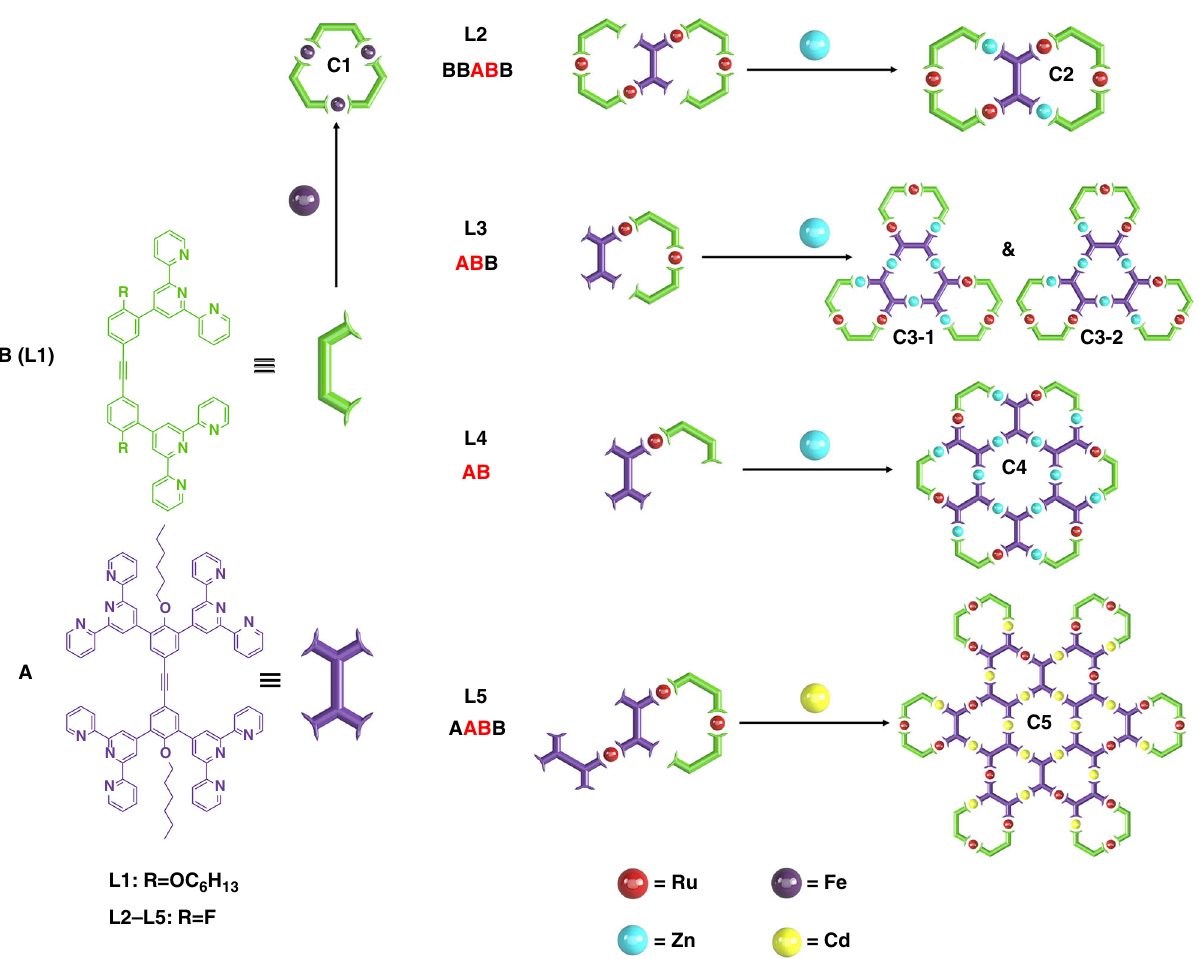
Fig. 2 Design of linear metal-organic ligands L1 – L5 and corresponding supramolecules C1 – C5 . C1 : violet = Fe; C2 : cardinal = Ru, blue = Zn; C3 – 1 & C3 – 2 : cardinal = Ru, blue = Zn; C4 : cardinal = Ru, blue = Zn; C5 : cardinal = Ru, yellow =